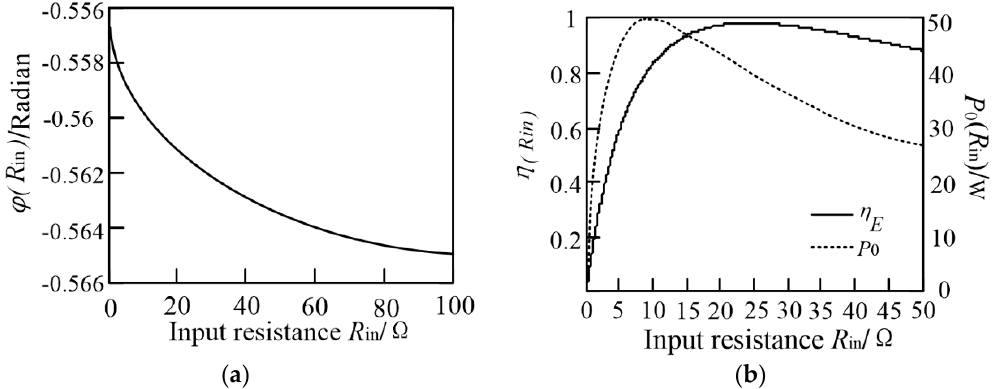
Figure 5. (a) Current phase with respect to R in ; ( b ) Efficiency and output power with respect to R in